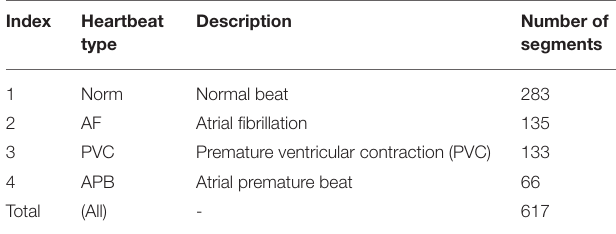
TABLE 1 | The statistics of heartbeat segments in the MIT-BIH arrhythmia database